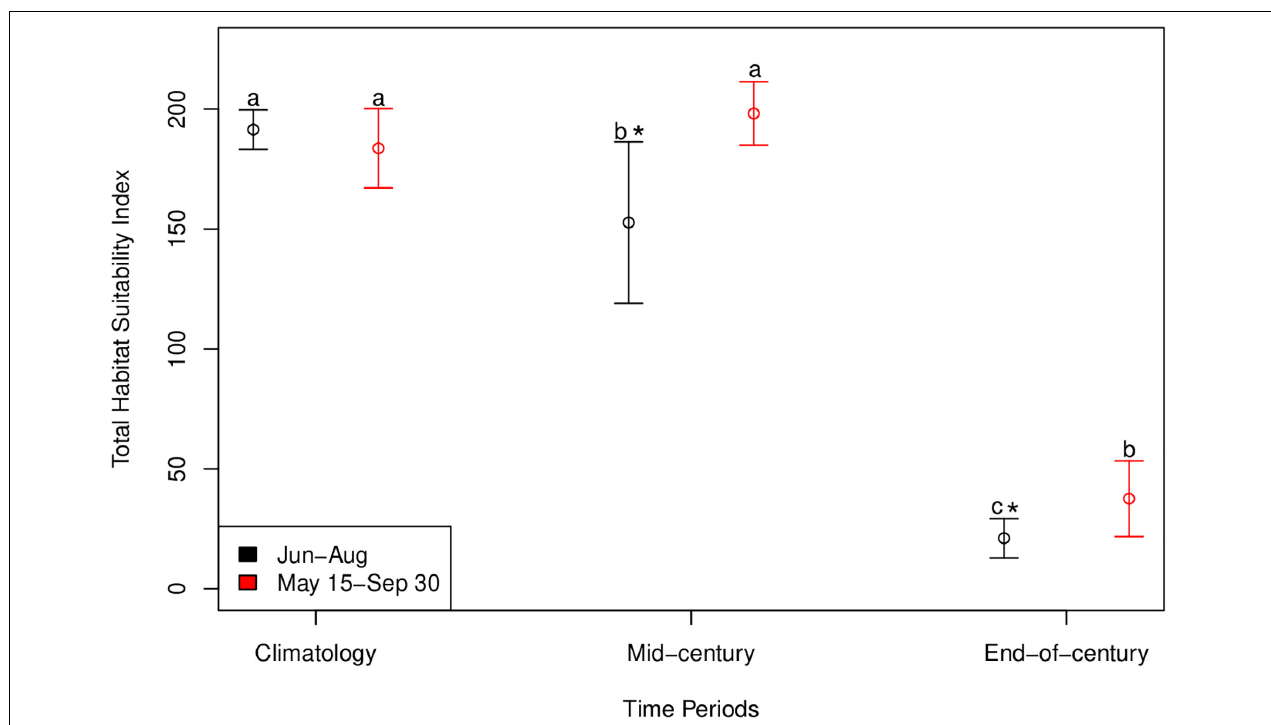
FIGURE 7 | Total habitat suitability index for cobia in Chesapeake Bay during contemporary, mid-century, and end-of-century time periods for each summer period (Jun–Aug and May 15–Sep 30). Error bars represent standard deviation. Black symbols represent the mean total habitat suitability index values for June–August and red symbols represent the mean total habitat suitability index values for May 15–September 30. Different lower case letters indicate a statistical difference among time periods within a summer period. For example, in the Jun-Aug summer period all three times periods are different from one another. An * indicates a statistical difference between summer periods within a time